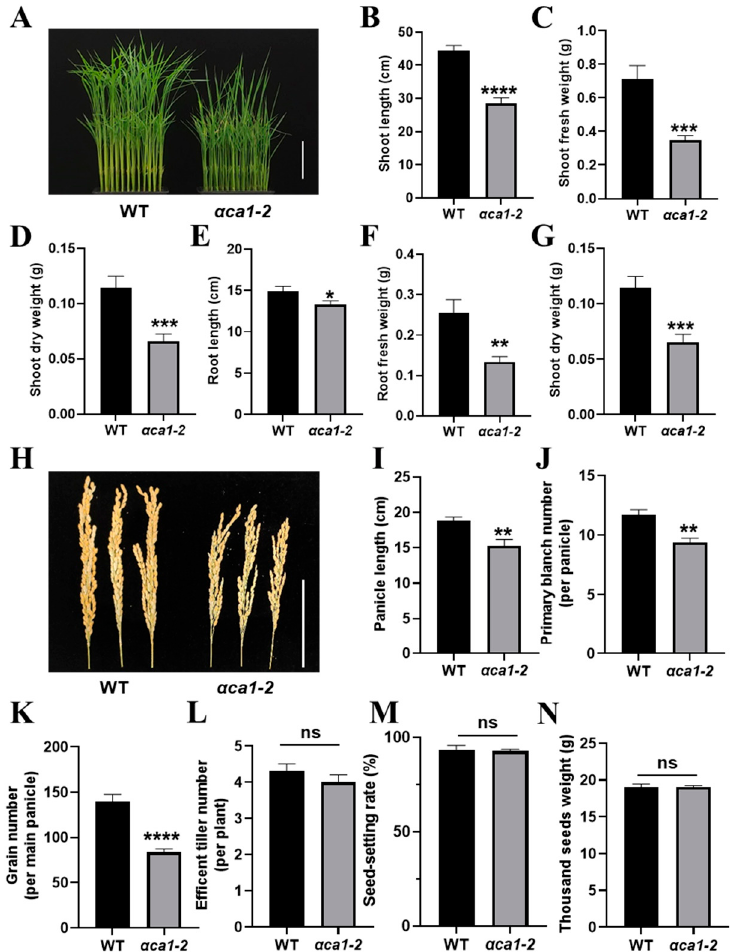
Figure 3. The disruption of Os α CA1 restricted biomass production and grain yield in rice. ( A ) The representative image of 15-day-old WT and α ca1-2 seedlings. Scale bar: 10 cm. ( B – G ) The plant growth of 3-week-old seedlings of WT and α ca1-2 . ( B ) Shoot length; ( C ) shoot fresh weight; ( D ) shoot dry weight; ( E ) root length; ( F ) root fresh weight; ( G ) root dry weight. ( H ) The representative image of WT and α ca1-2 panicles. Scale bar: 10 cm. ( I – N ) The yield potential of WT and α ca1-2 . ( I ) Panicle length; ( J ) primary branch number; ( K ) grain number per main panicle; ( L ) efficient tiller number; ( M ) seed-setting rate; ( N ) thousand-seed weight. All values are shown as means ± SEM determined via Student’s t -test, where * p < 0.05, ** p < 0.01, *** p < 0.001, **** p < 0.0001, ns indicates no signi fi cant di ff erence, and n ≥ 20.